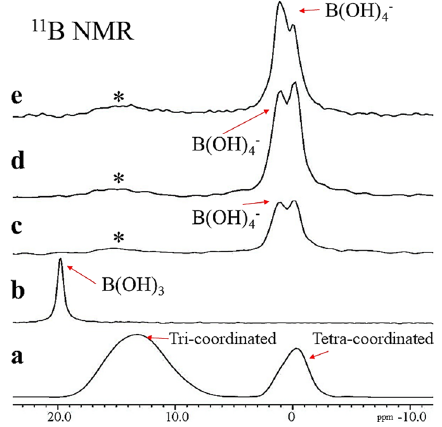
Figure 1. 11 B MAS NMR spectra, ( a ) S-PRG fillers, ( b ) S-PRG eluate, ( c ) S-PRG treated dentin, ( d ) S-PRG treated enamel, ( e ) S-PRG treated